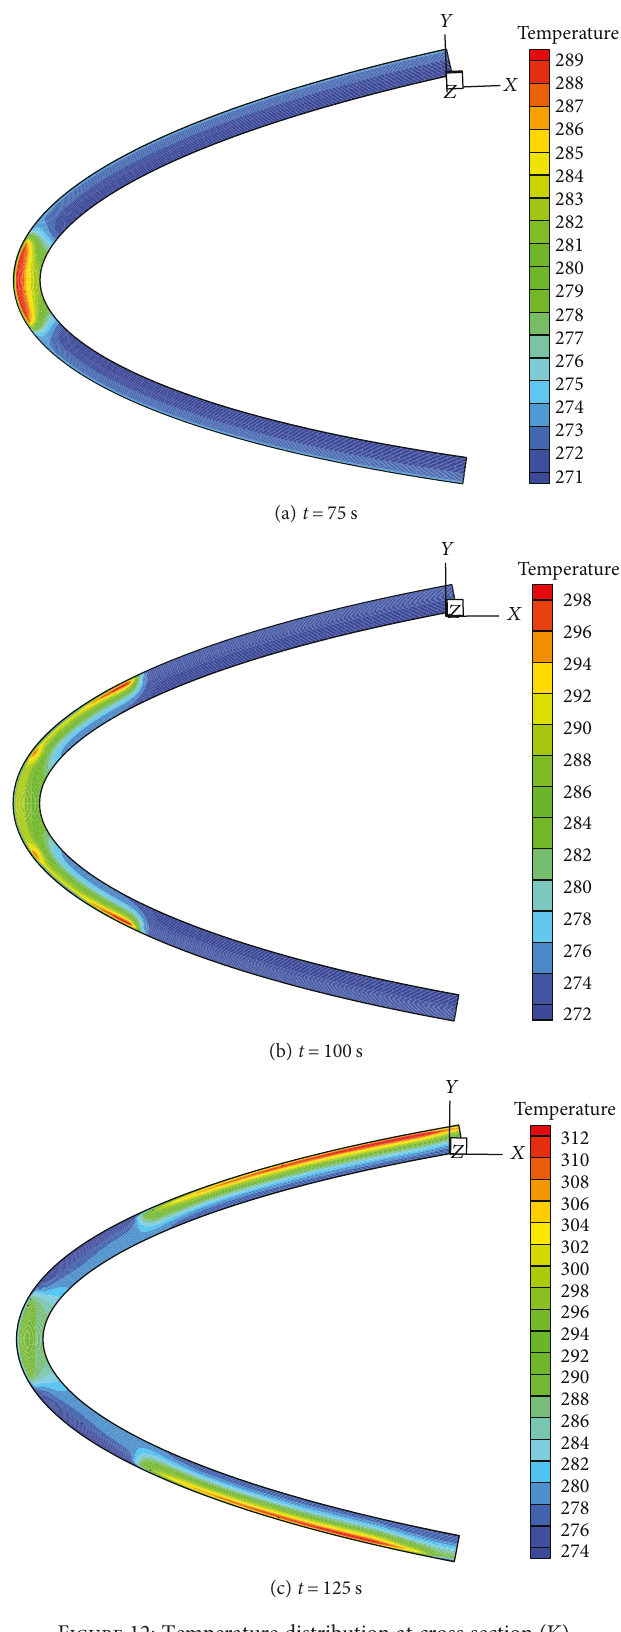
Figure 12: Temperature distribution at cross section